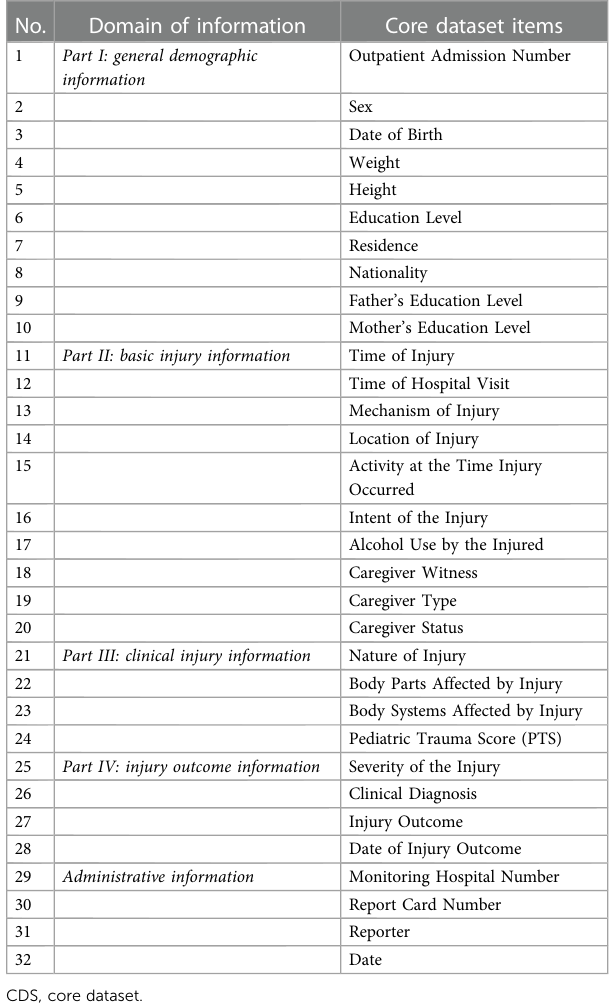
TABLE 3 Items included in fi nal version of Child Injury Surveillance CDS.